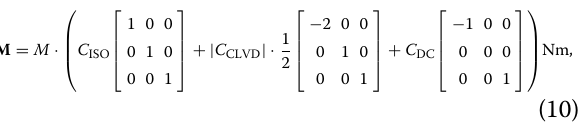
s , c s s , c where d t and t denote the data and synthetic time s and component c .